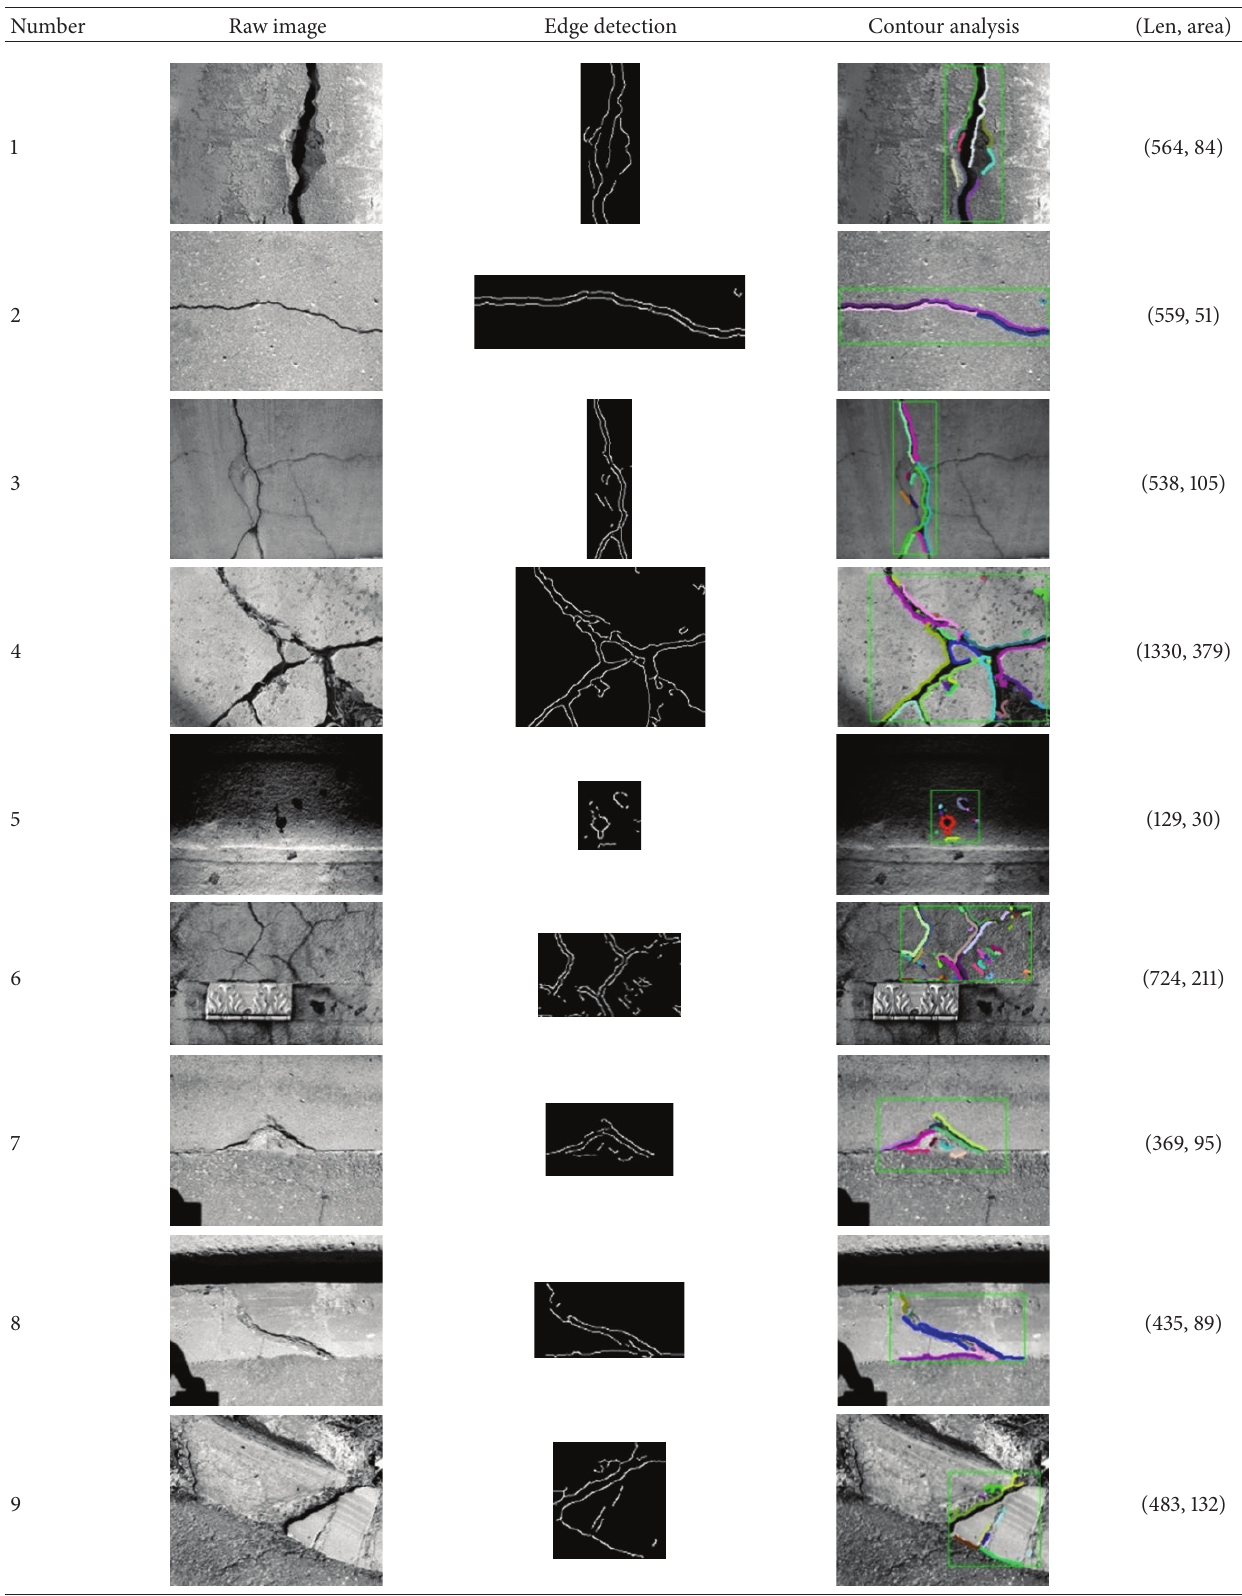
Table 2: Context-enabled image analysis and quantification for concrete crack